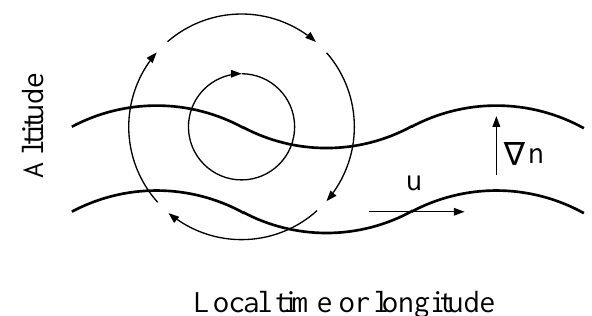
Fig. 6. Diagram illustrating the geometry of bottom-type layer gen- eration. The heavy curves are isodensity lines, and the concentric circles represent the circulation associated with the evening vortex. Regions where the horizontal wind is large in the plasma rest frame and antiparallel to a component of the density gradient are gradi- ent drift unstable. Convection due to the evening vortex or another agent produces horizontal conductivity gradients which are alter- nately stable and